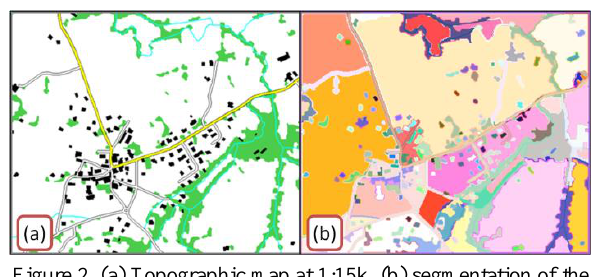
Figure 2. (a) Topographic map at 1:15k. (b) segmentation of the map (a random color is assigned to each object) When the segmentation threshold k increases, the number of segmented objects decreases and Bravo and Farid (2008) identified that it fitted with a power law (Equation 3) whose constant increases in cluttered images. This constant is then used as a measure of